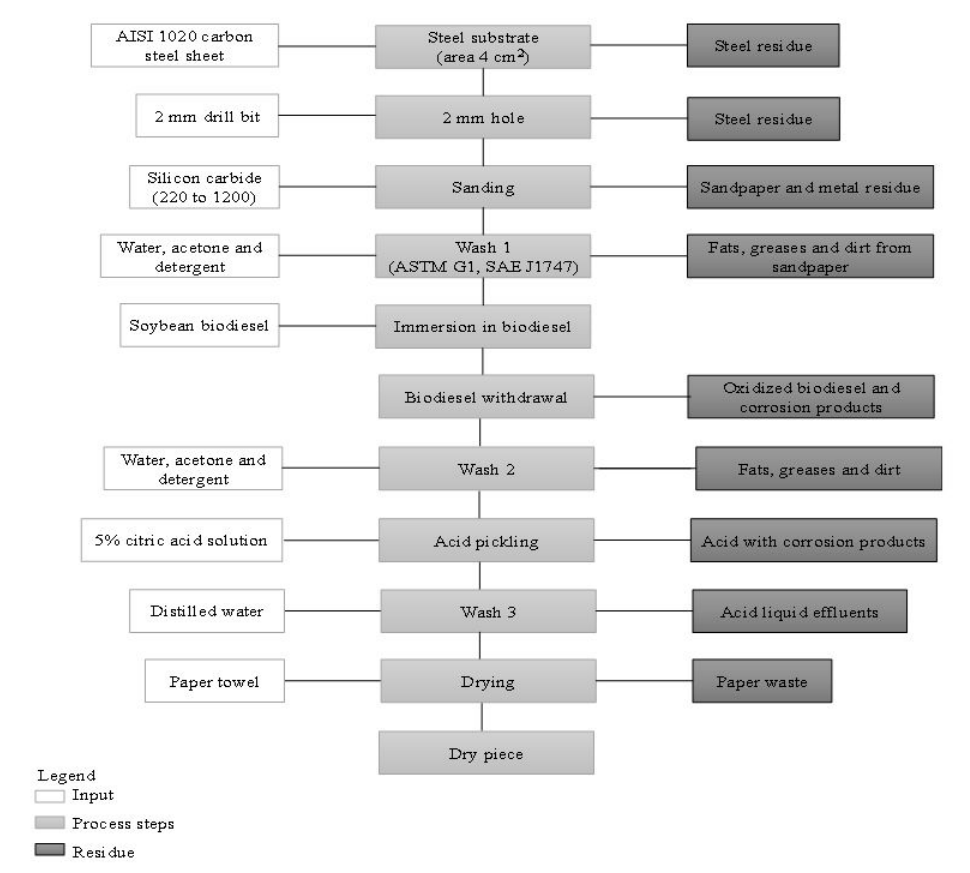
Figure 2. Flowchart of the procedure used in the preparation of the